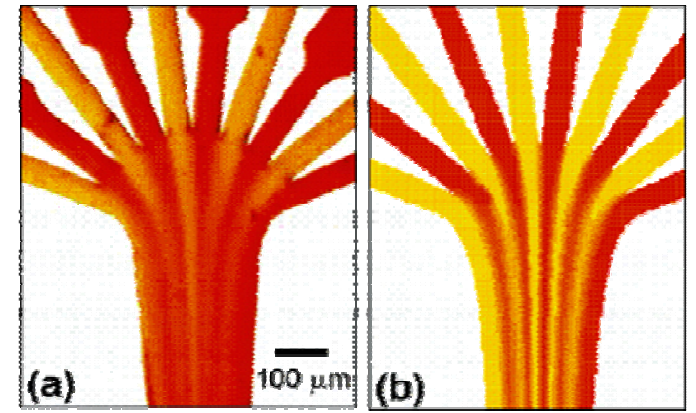
Figure 6. (a) Experimental and (b) numerical visualizations of fluid mixing in hydrodynamic focusing channels (from Floyd et al.